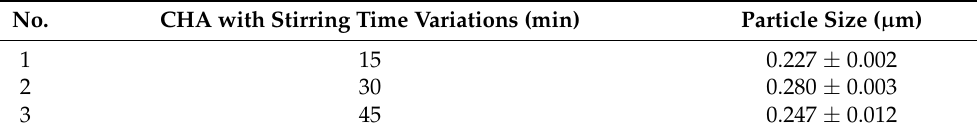
Table 1. Particle size distribution of CHA.